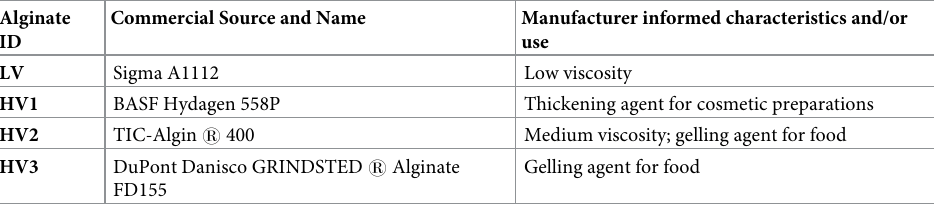
Table 1. Commercially sourced alginates used in this